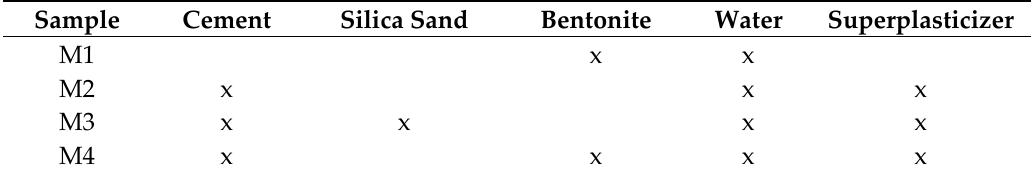
Table 1. Samples and materials used.